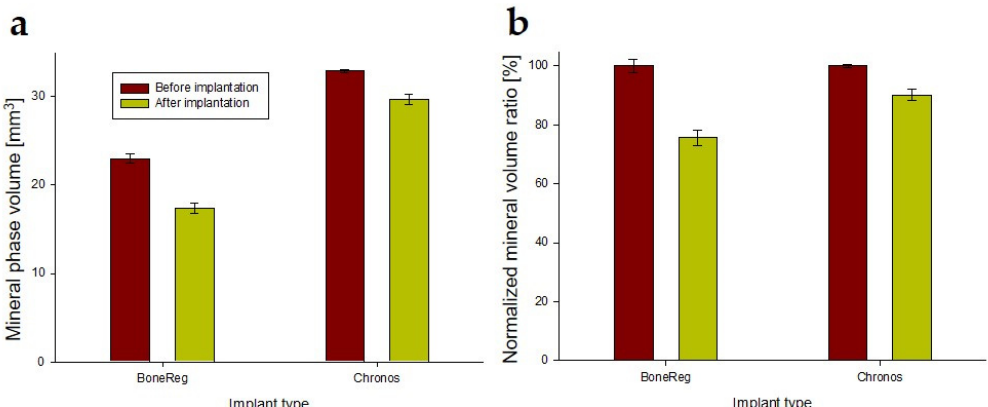
Figure 2. ( a ) Mineral phase volume inside the composites ex vivo (before implantation) and after 3 months in vivo , measured in spheres (radius 2 mm). ( b ) Bars show mineral phase volume before implantation normalized to 100% for both composites and their relative reduction during 3 months in vivo. Mineral phase volume in BoneReg-Inject™ group ( n = 15) is reduced by 21% and in chronOS Inject ® ( n = 14) by 10%. (Student’s t -test; p < 0.001). Means and SEM (BoneReg-Inject™ n = 15; chronOS Inject ® n =